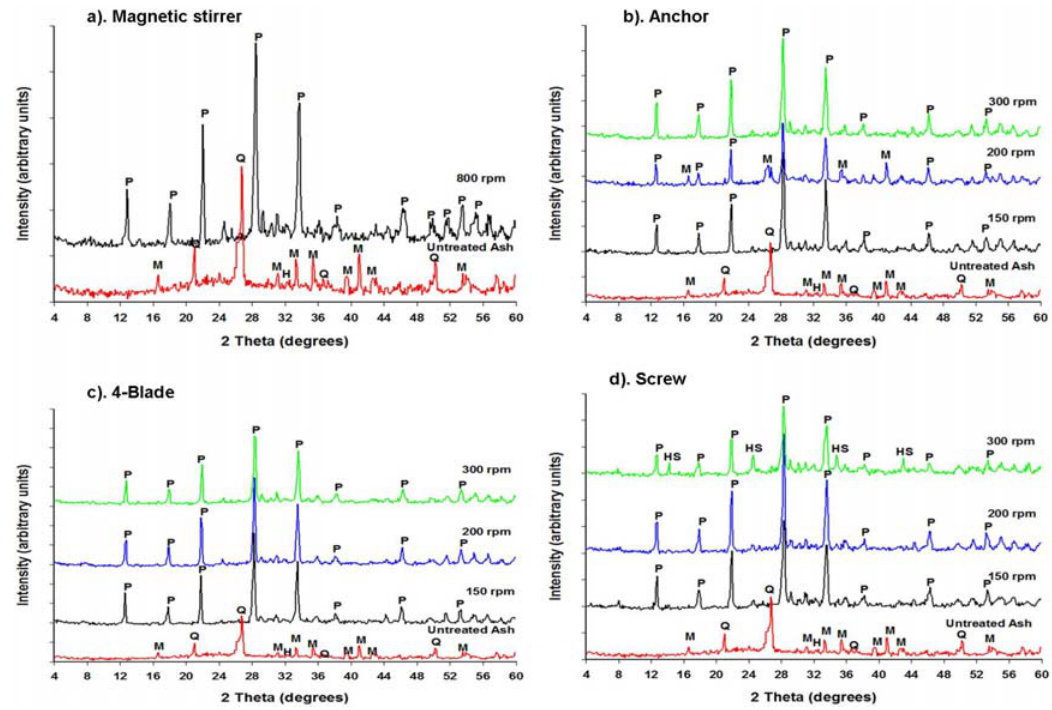
Figure 3. XRD spectra of the products synthesized using ( a ) Magnetic stirrer; ( b ) Anchor; ( c ) 4-Flat blade; and ( d ) Archimedes screw impeller at different stirring speeds during the ageing at 47 °C for 48 hours. (P = Zeolite Na-P1, Q = Quartz, M = Mullite, HS = Hydroxysodalite).